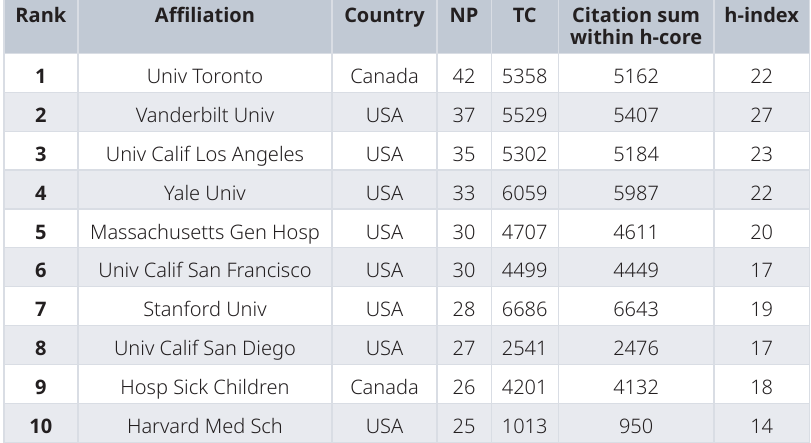
Table 3. Top ten organization-wise research in